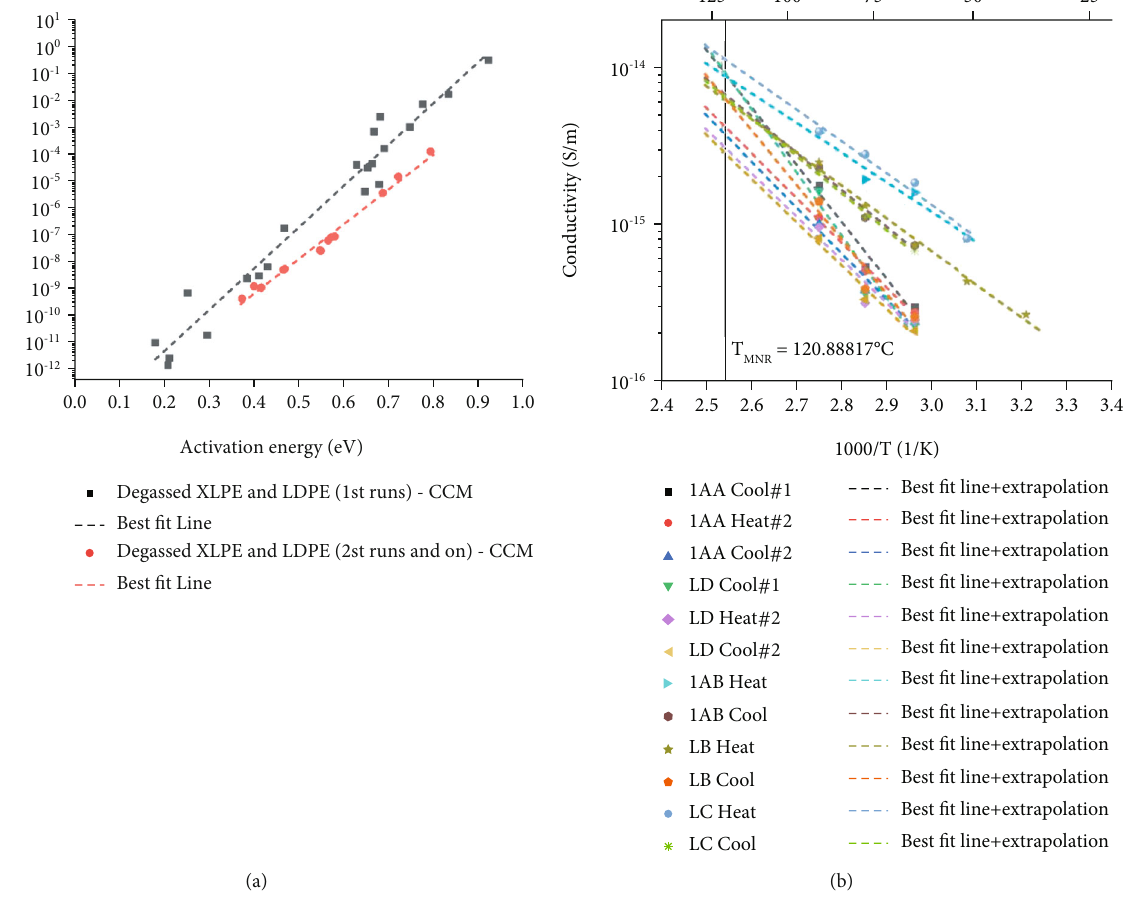
Figure 9: (a) Compensation plot comparing all the XLPE and LDPE samples to the runs shown in Figure 6 after initial runs or treatments. (b) Extrapolated conductivity at the nominal “ isokinetic point ” of 120.9 ° C for the same samples plotted in red. Legend is shown separately below the conductivity